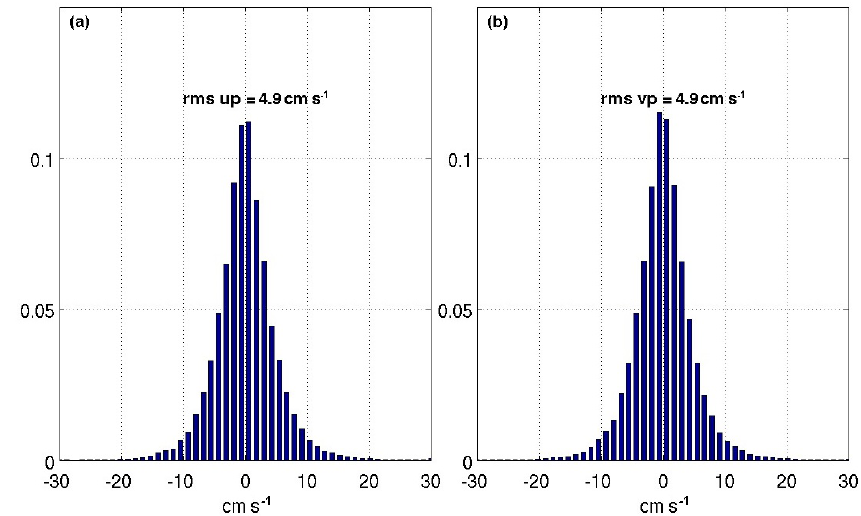
Figure 4. Normalized distribution of the mid-depth eddy velocity components; (a) is u (cid:48) (east–west component) and (b) is v (cid:48) (north–south component) – Gaussian distribution with equal rms of 4.9cms − 1